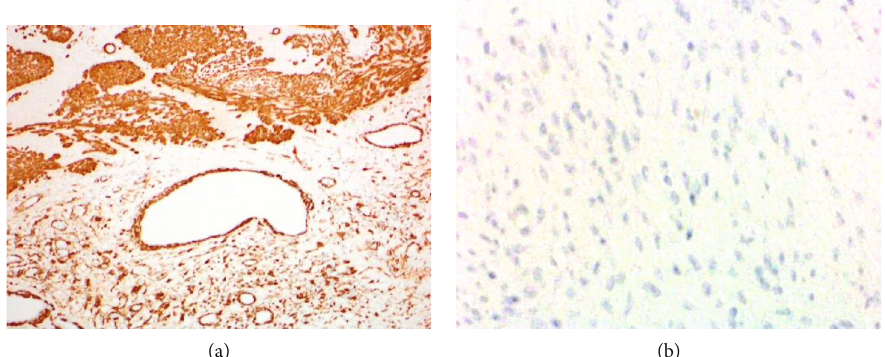
Figure 4: (a) Immunohistochemical stain for smooth muscle actin (SMA) featuring positive staining of normal muscle fi bers of the stomach, walls of blood vessels, and spindle tumor cells. (b) Immunohistochemical stain for CD117 (C-Kit), a marker for GIST, featuring negative staining of spindle tumor